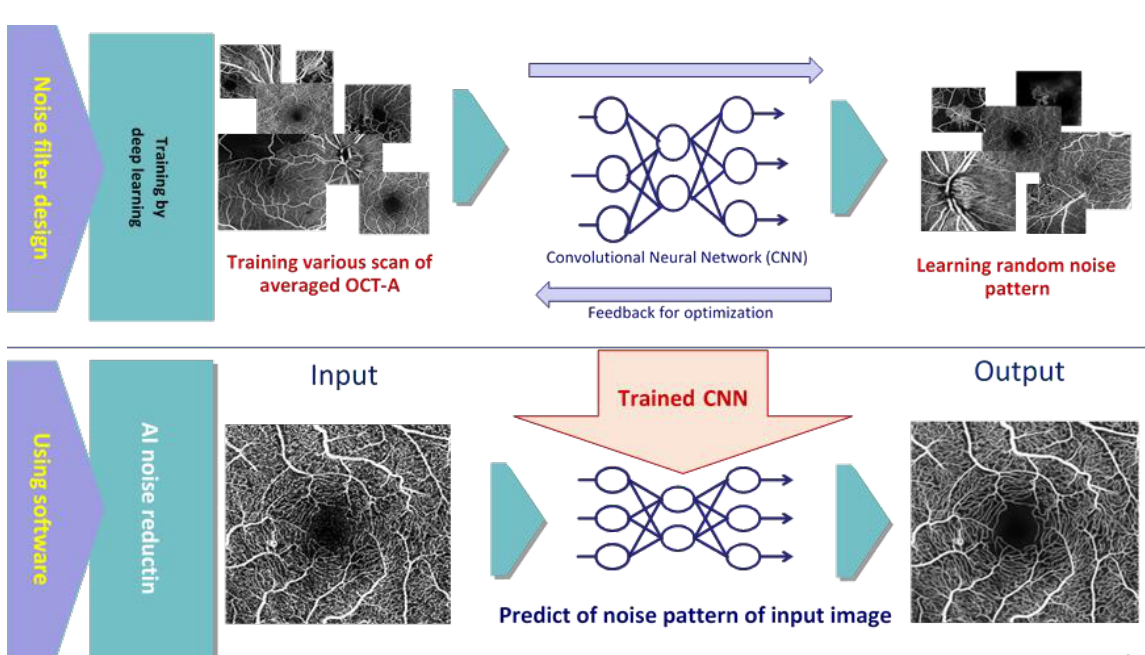
Figure A1. Deep learning denoise model schematic.